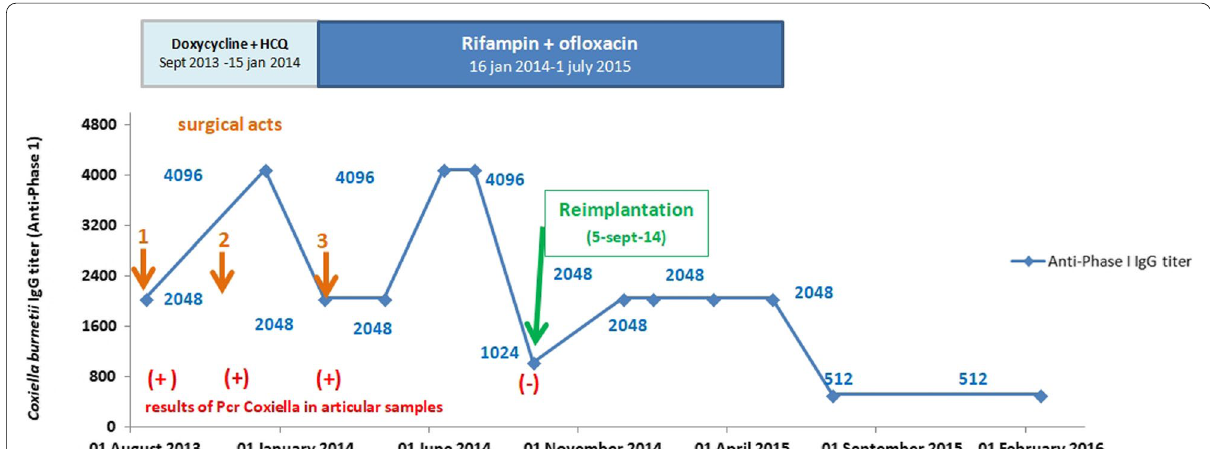
Fig. 2 Kinetics of anti-phase I IgG titers (all previous sera were usually but not systematically analyzed in parallel) and results of the specific coxiella PCR during antimicrobial therapy and surgical procedures according to immunofluorescence assays. The Ct of the specific PCR (Smartcycler), when positive, was respectively 33.7, 31.3 and 24.6. Notes: HCQ Hydroxychloroquine. Surgical acts: the first was performed on the 6th, August 2013, the = second the 29th, October 2013 and the third, the 15th, January